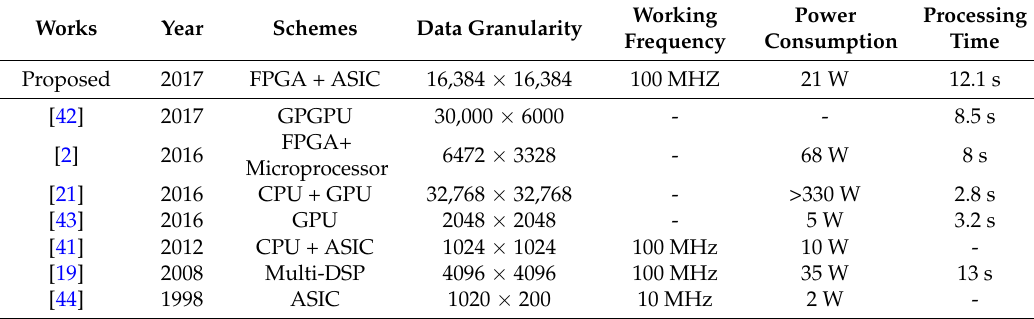
Table 12. Comparison with previous